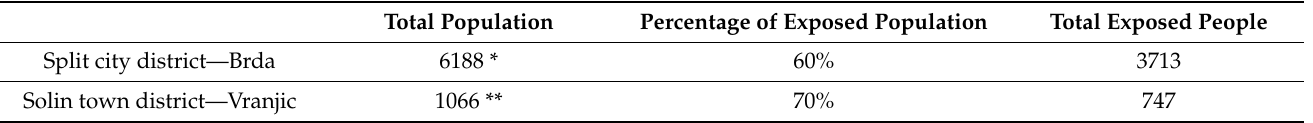
Table 3. Total number of people exposed to noise from cargo terminals in the port of Split. Total Population Percentage of Exposed Population Total Exposed People Split city district—Brda 6188 *